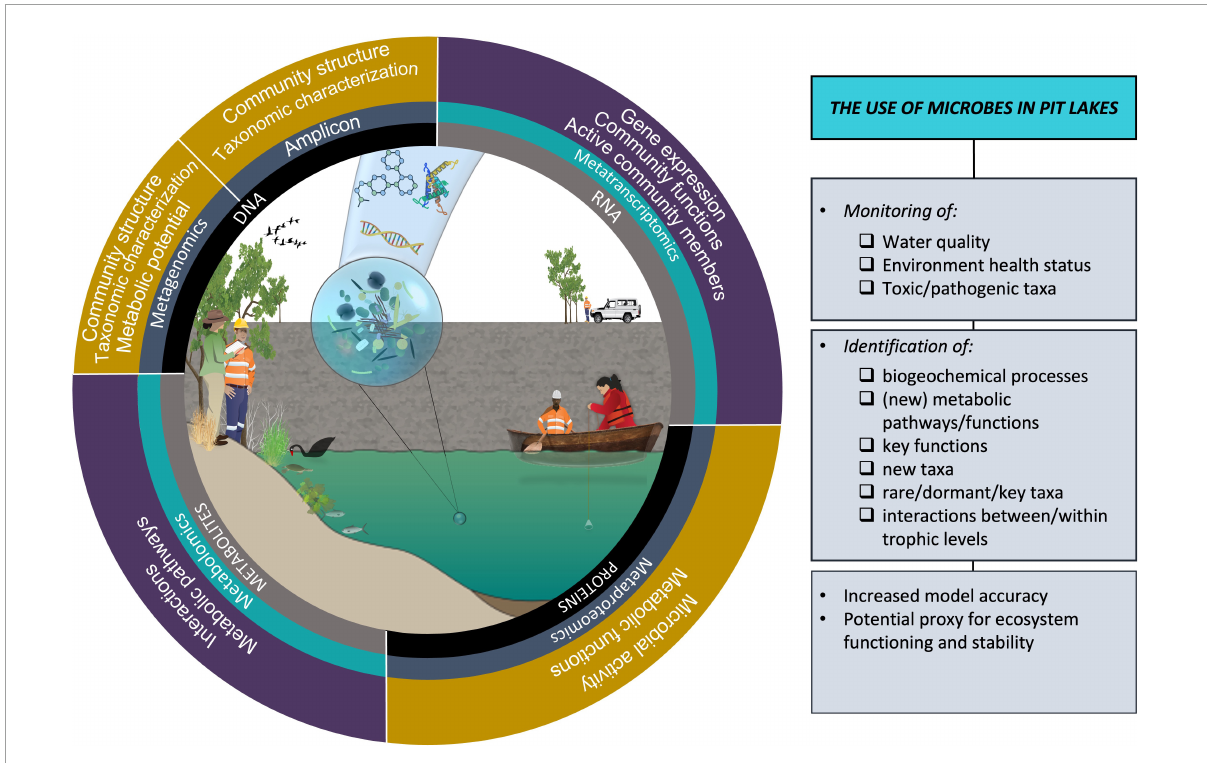
FIGURE2 Microbes can be used in pit lakes for environmental monitoring and identification of processes and taxa. Harnessing new technology will advance the field of pit lake microbiology. Symbols curtesy of Integration and Application Network (ian.umces.edu/symbols/) and NESP Resilient Landscapes Hub